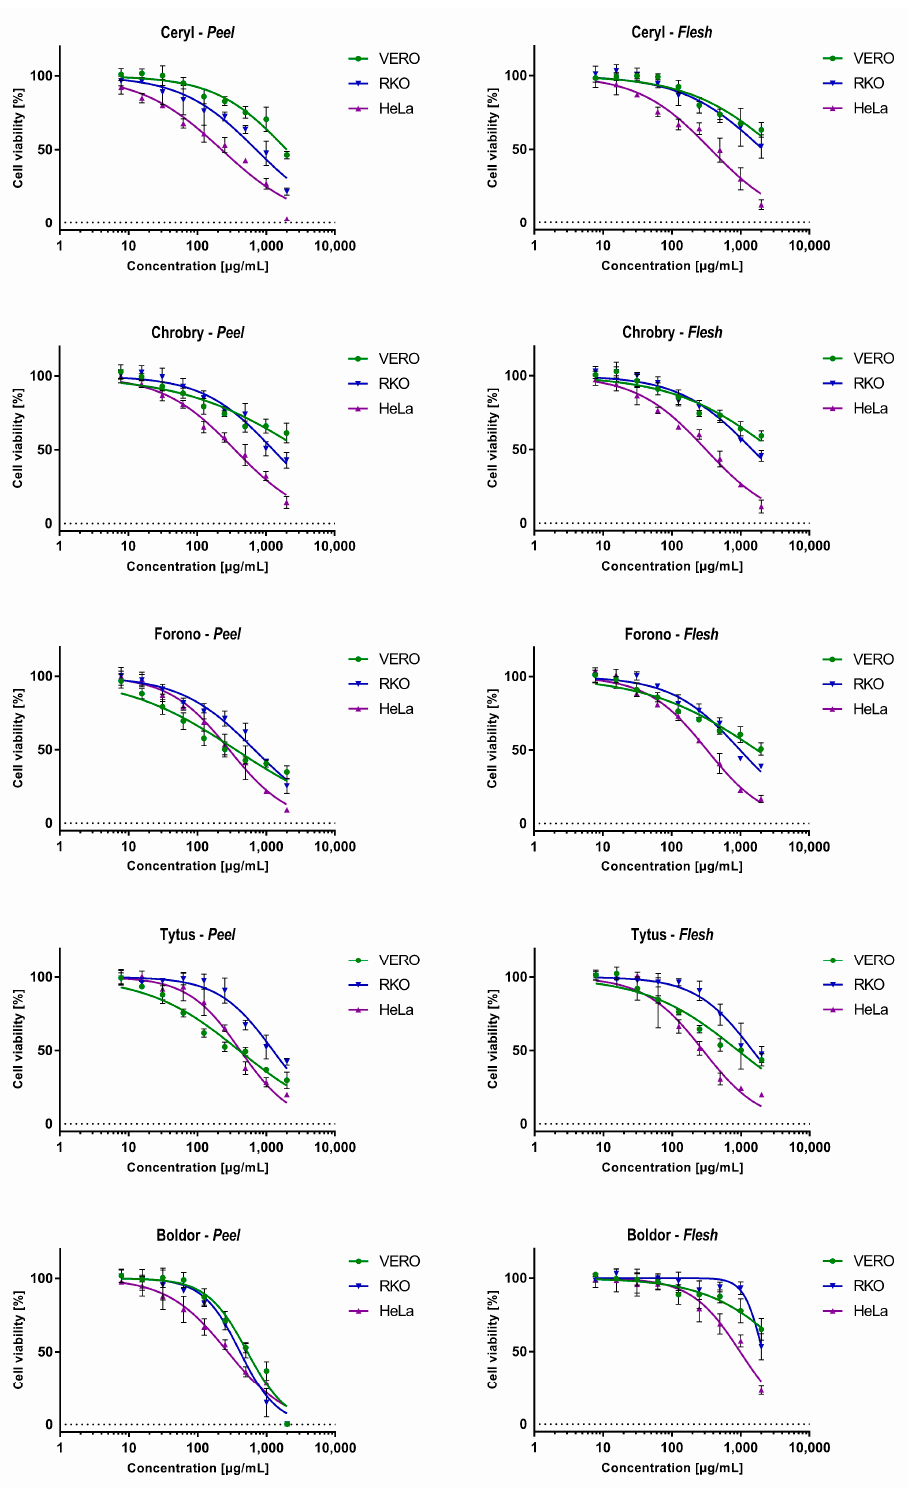
Figure 6. The dose-response impact of extracts from red and yellow B. vulgaris cultivars on non- cancerous and cancer cell lines.